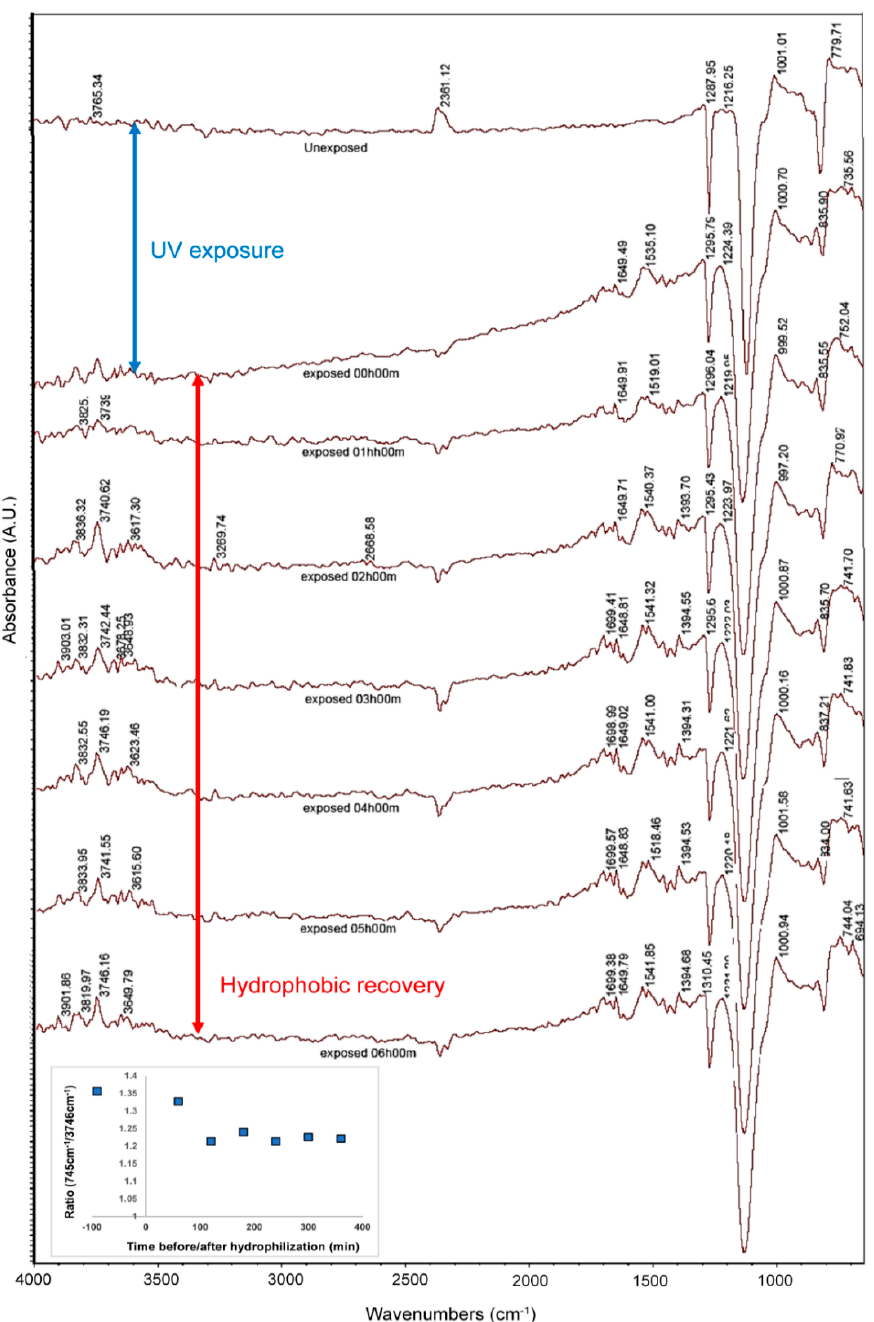
Figure 3. Evolution of the FTIR-ATR spectra of flat PDMS surfaces, before and immediately after hydrophilization, and at different times after.